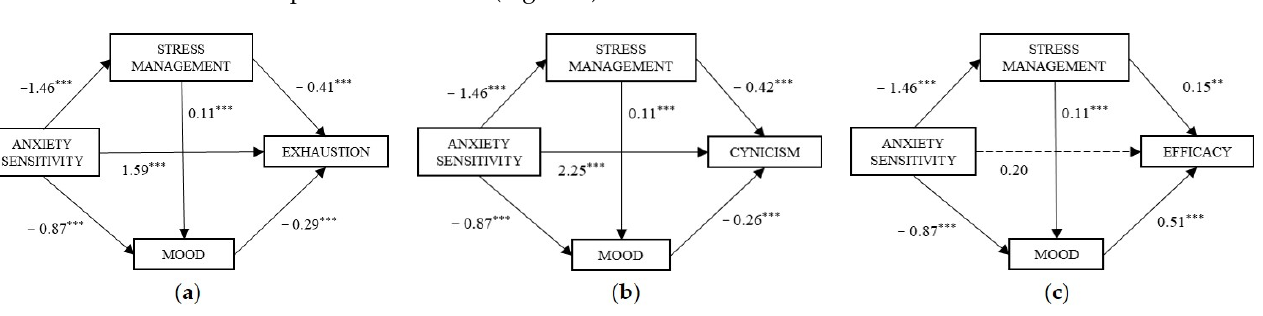
Figure 2. Statistical diagrams of the direct effects on the mediation models proposed. [Note. ( a ) Anxiety sensitivity and Exhaustion; ( b ) Anxiety sensitivity and Cynicism; ( c ) Anxiety sensitivity and Efficacy. ** p < 0.01, *** p < 0.001].